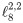
ℓ-graphs of order 8.From the symbolic computation of the differences Φ(r) − Φ0(r), we know that the graphs ℓ82,2, ℓ82,3 and ℓ81,4 (with identification numbers Id 38605195624473, Id 38605195632653 and Id 38605187250242) have a unique transition of type Suppressor/Amplifier at rc ≈ 4.15, rc ≈ 5.32 and rc ≈ 1.89 respectively.